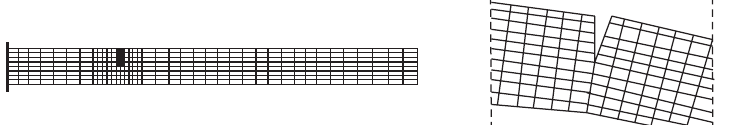
Figure 3: Finite element mesh and mesh zoom of the